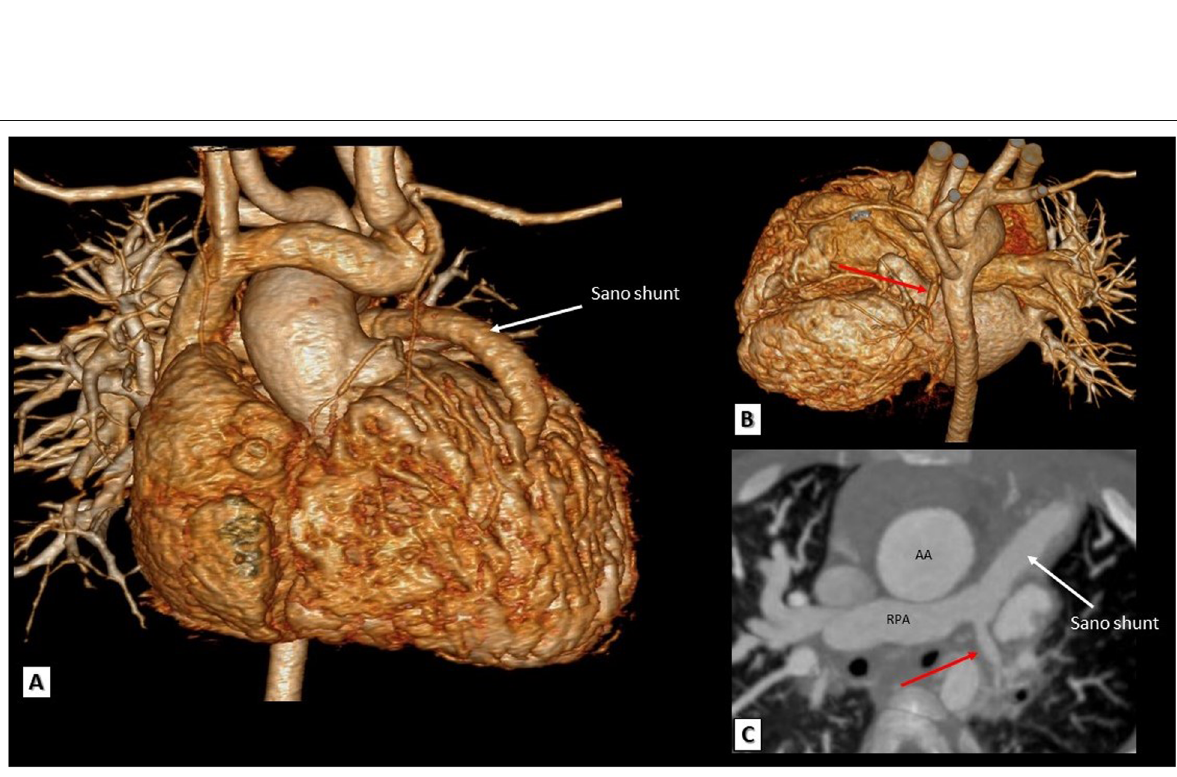
Fig. 11 A TOF patient with Sano shunt. a , b 3D VRT and c a reformatted axial MDCT image showing a patent Sano shunt between the RV and the distal main pulmonary artery. Note the hypoplastic left pulmonary artery (red arrows). AA, ascending aorta; RPA, right pulmonary